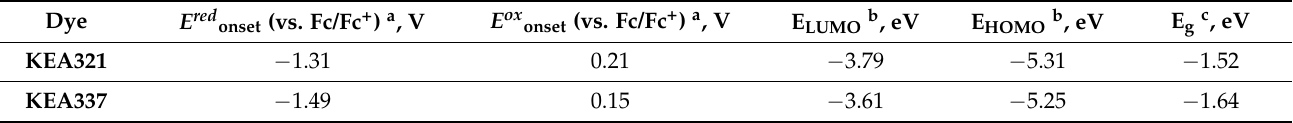
Figure 5. CV curves of KEA321 and KEA337 in DMF solution (0.1 M Bu 4 NClO 4 ) on platinum electrode at 0.1 Vs − 1 potential sweep rate. Table 6. Electrochemical properties of the KEA dyes in DMF